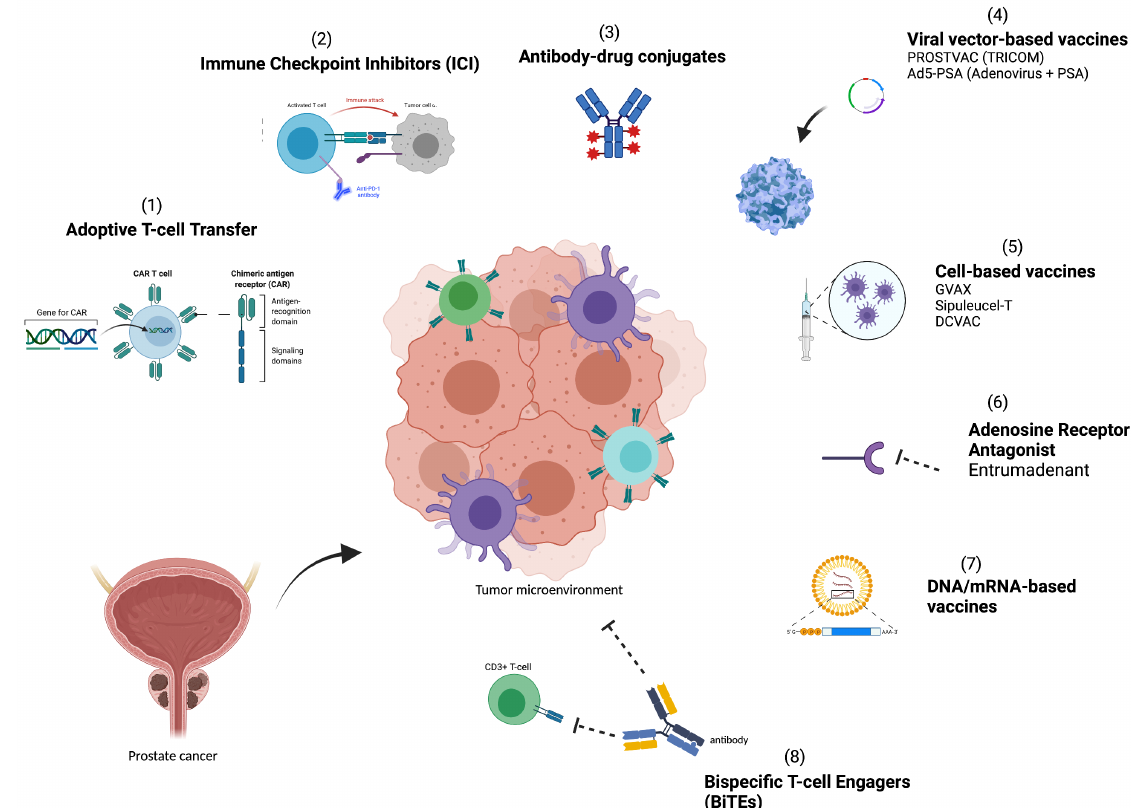
Figure 1. Immunotherapeutic categories designed to overcome immune resistance mechanisms in the tumor microenviron- ment of prostate cancer: ( 1 ) adoptive cell transfer, ( 2 ) Immune checkpoint inhibitors, ( 3 ) antibody–drug conjugates, ( 4 ) viral vector-based vaccines, ( 5 ) cell-based vaccines, ( 6 ) Adenosine receptor antagonists; ( 7 ) DNA/mRNA- based vaccines, and ( 8 ) Bispecific T-cell